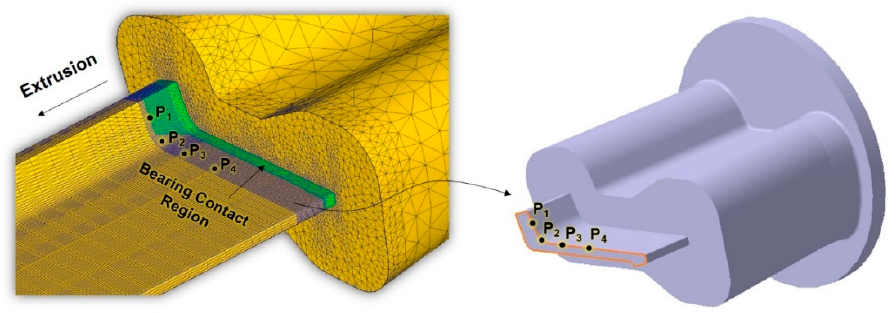
Figure 9. Locations used to evaluate the mechanical responses with the variation in ram speed.